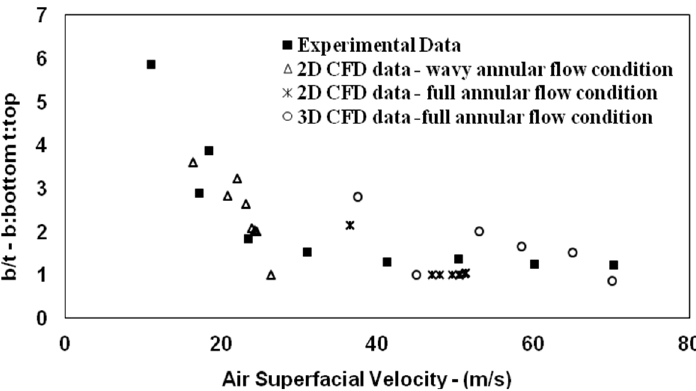
Figure 15. CFD predicted air flow superficial velocity variations with the ratio of bottom/top ( b/t ) film thickness, compared with the experimental data